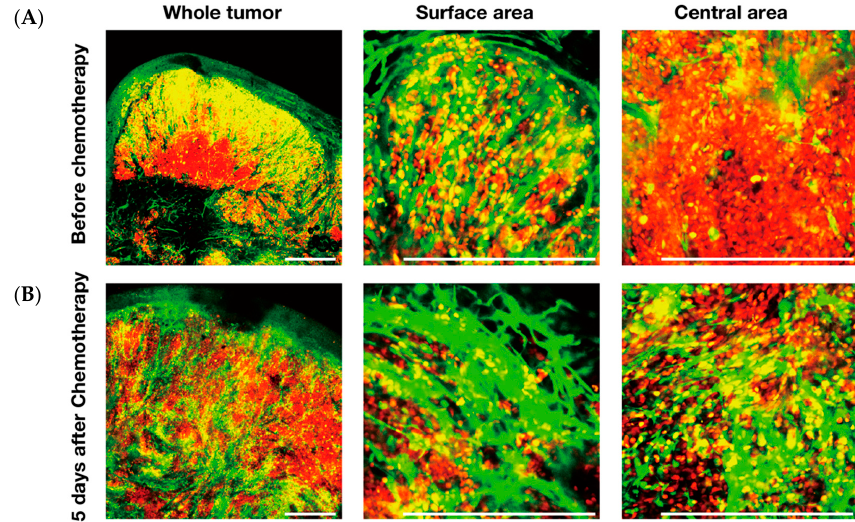
Figure 8. Cytotoxic chemotherapy induces tumor angiogenesis. ( A ) Representative images of FUCCI ‐ expressing tumors with visualized GFP ‐ expressing tumor vessels before chemotherapy. ( B ) Representative images of FUCCI ‐ expressing tumors with visualized GFP ‐ expressing tumor vessels after chemotherapy. Elongated green structures are GFP ‐ expressing nascent tumor vessels formed in transgenic mice expressing nestin ‐ driven GFP [40,48]. Scale bar; 500 μ m.